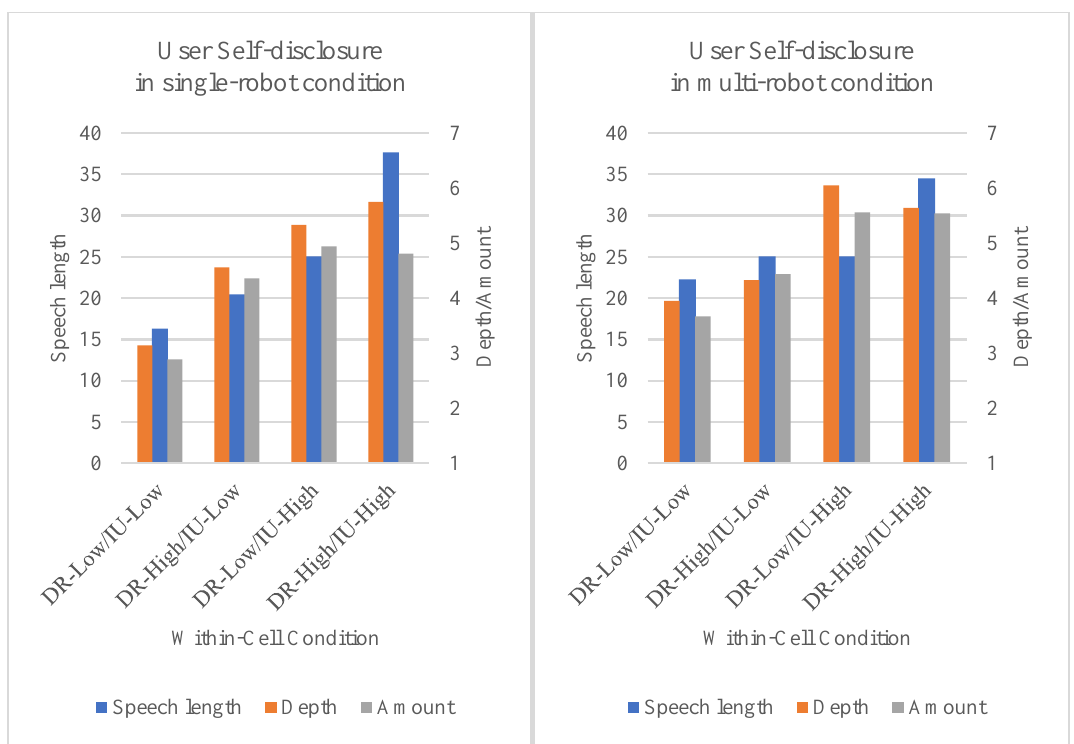
Figure 4. DV measurement results (user self-disclosure). DR: disclosing robot; IU: involving user .